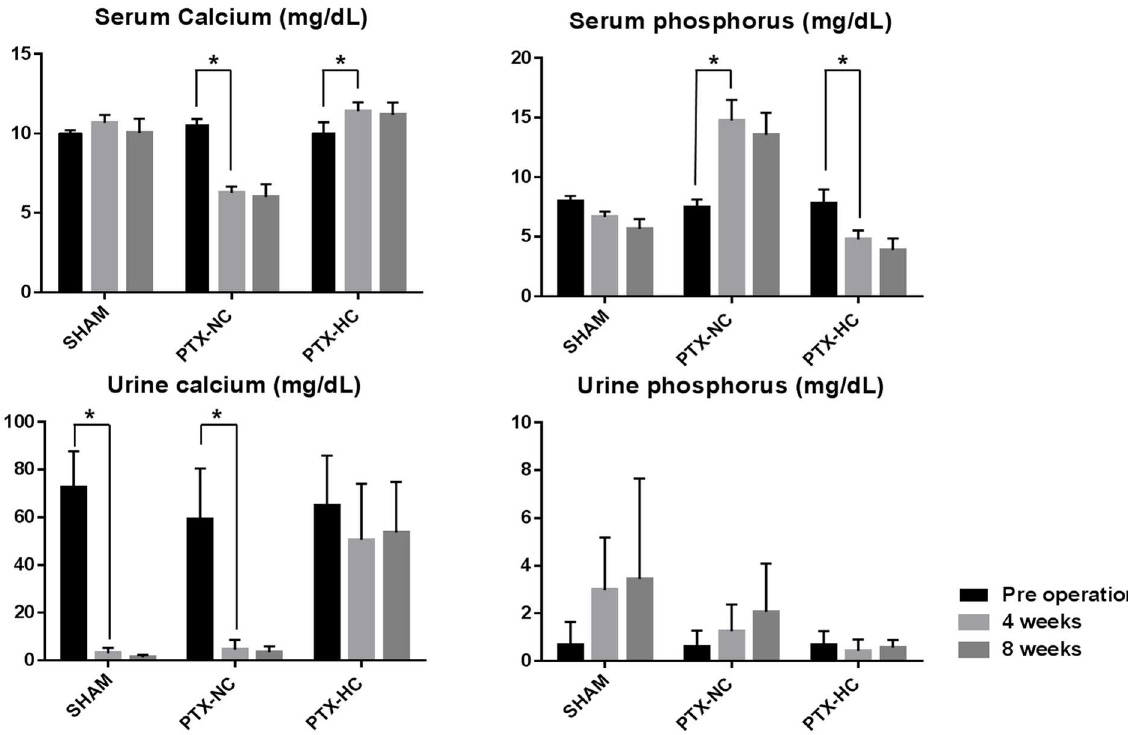
Fig 4. Calcium and phosphorus levels. Serum calcium levels decreasedand serum phosphorus increasedin the PTX-NC group after parathyroidectomy. Urine calcium levels decreasedin all groups but the decrease was smallest in the PTX-HC group. Urine phosphorus increasedin the SHAM and PTX-NC groups.